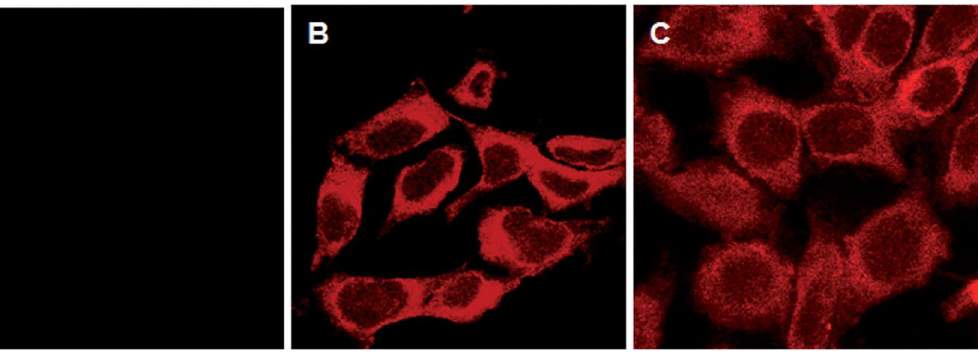
Figure 30: Cellular uptake by confocal laser microscopy. Images of B78-H1 cells (A) untreated and treated with 400 nm Rhod-TAT-SPION-TPP after incubation for (B) 3 h and (C) 24 h [68]. With permission from John Wiley and Sons.